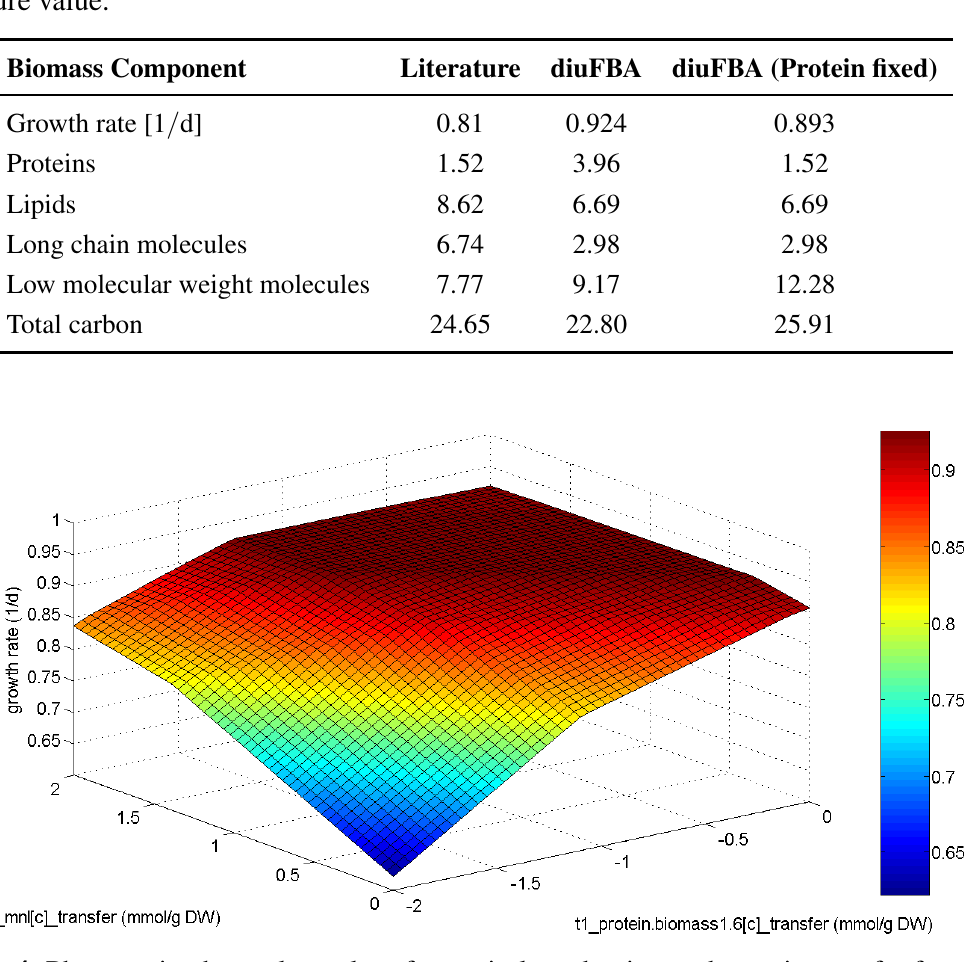
Figure 4. Phenotypic phase plane plot of mannitol production and protein transfer from day to night. Negative numbers mean a transfer from night to